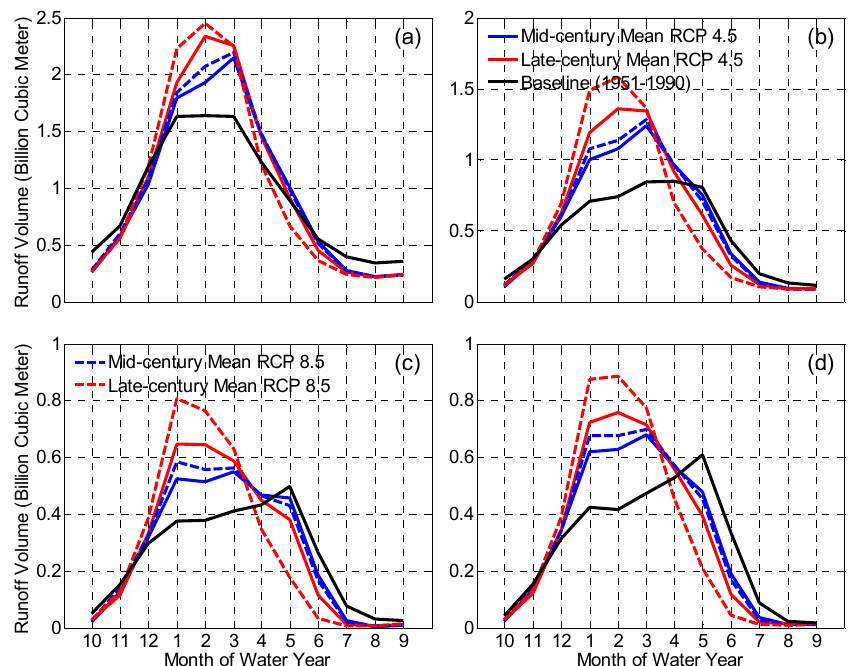
Figure A3. Monthly mean runoff projections for ( a ) Sacramento River above Bend Bridge, ( b ) Feather River, ( c ) Yuba River, and ( d ) American River under RCP 4.5 and RCP 8.5 projections, respectively.